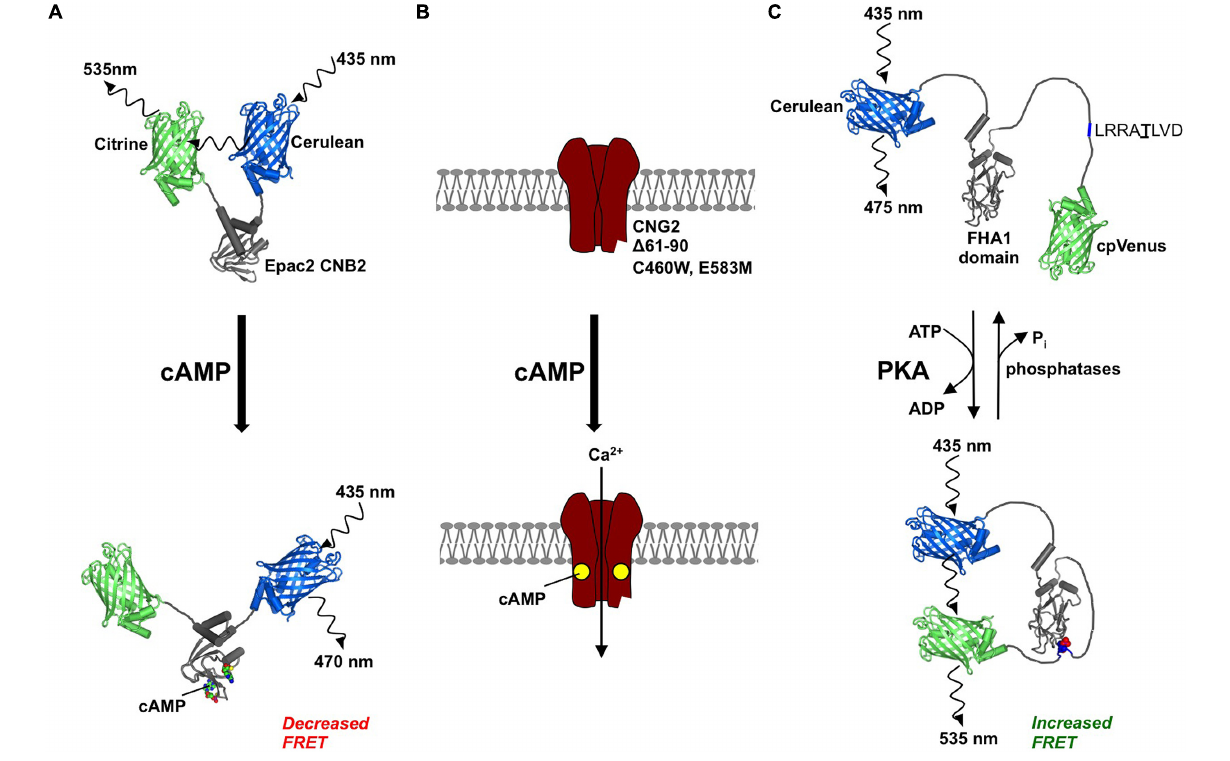
regulation, and the substitutions C460W/E583M for high affinity and specificity for cAMP. Elevation of cAMP leads to increased flux of Ca 2 + which can be detected using Ca 2 + dyes or by measuring current across the membrane. (C) AKAR4 contains a central FHA1 domain. PKA phosphorylation of threonine within the motif ‘LRRATLVD’ leads to association of phosphothreonine with FHA1, which can be detected as an increase in FRET between the terminal fluorescent